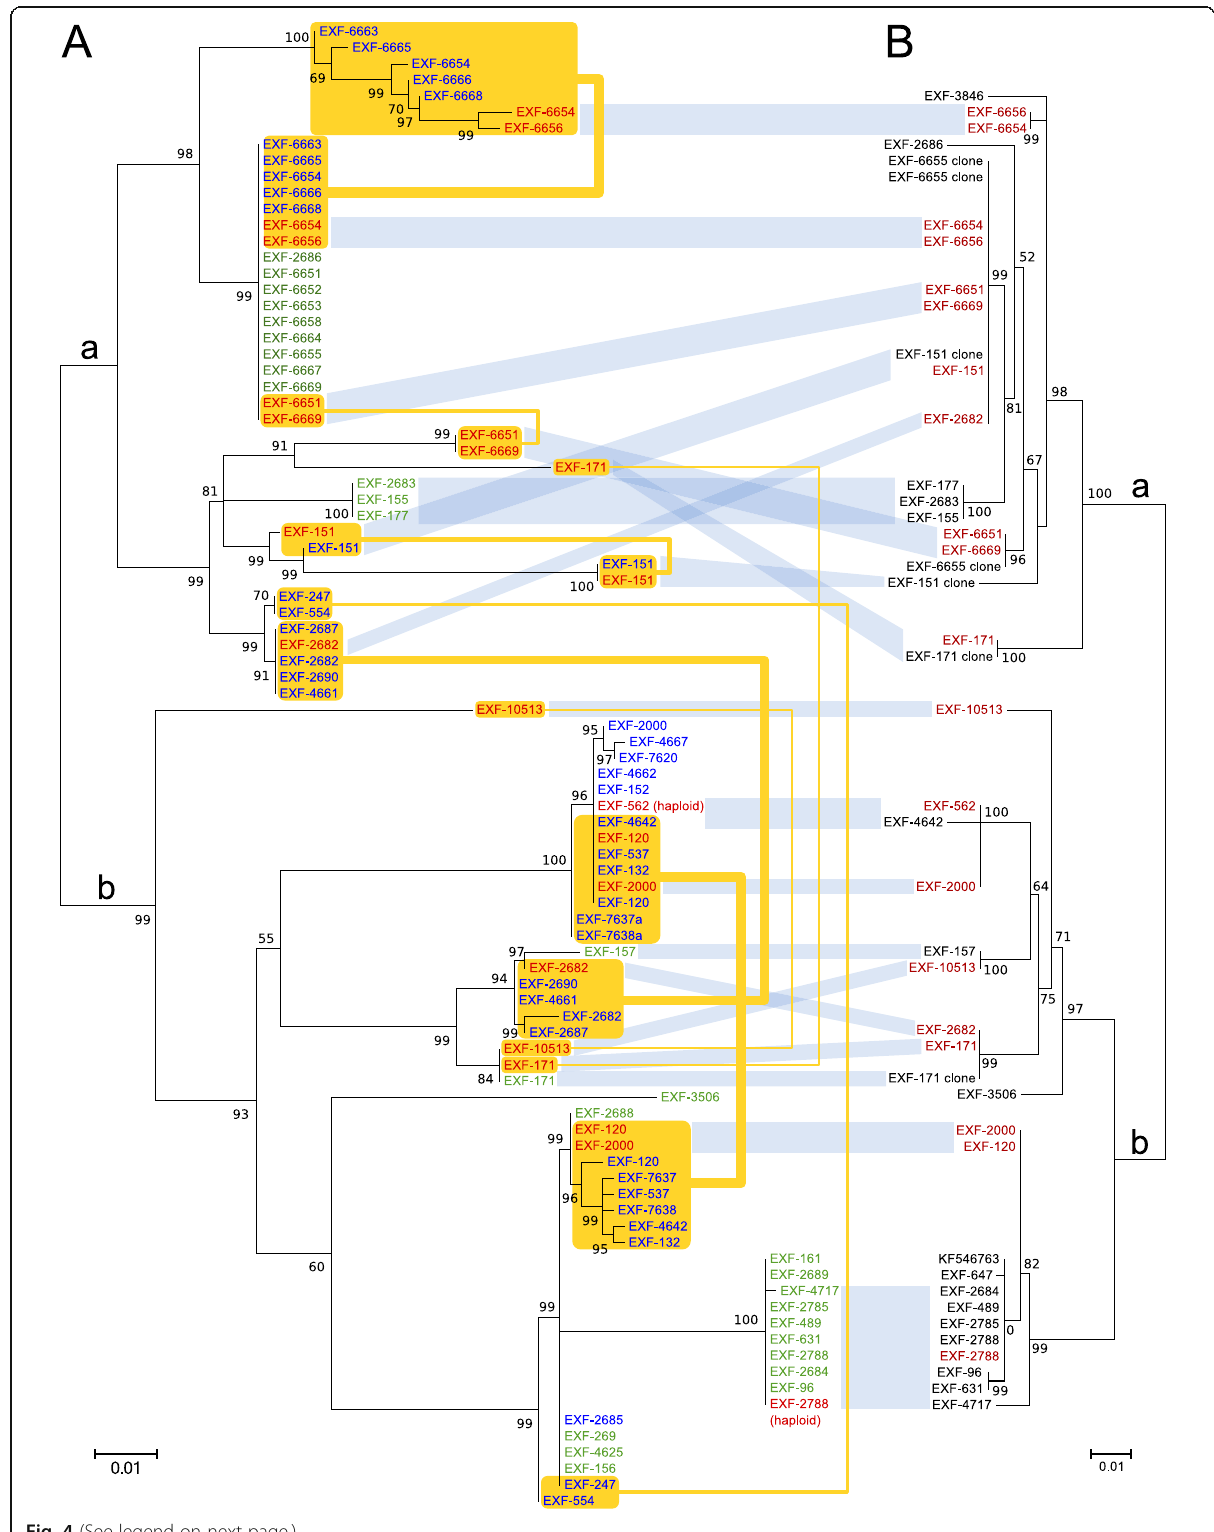
Fig. 4 (See legend on next